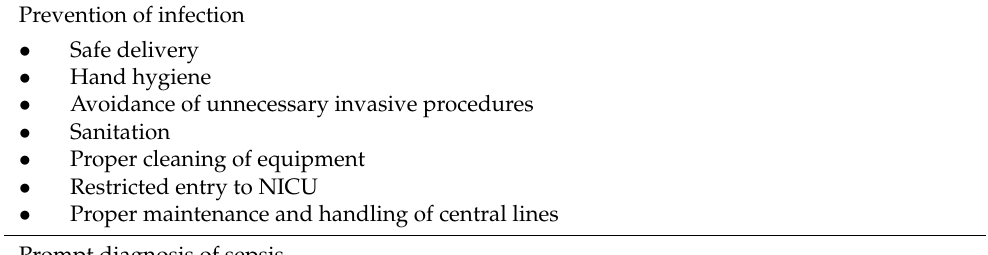
Table 3. Ways of fighting antibiotic resistance in